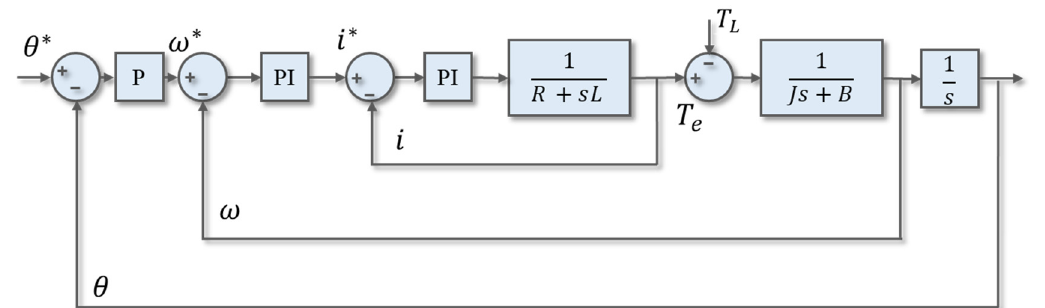
Figure 5. Servo motor control loop.